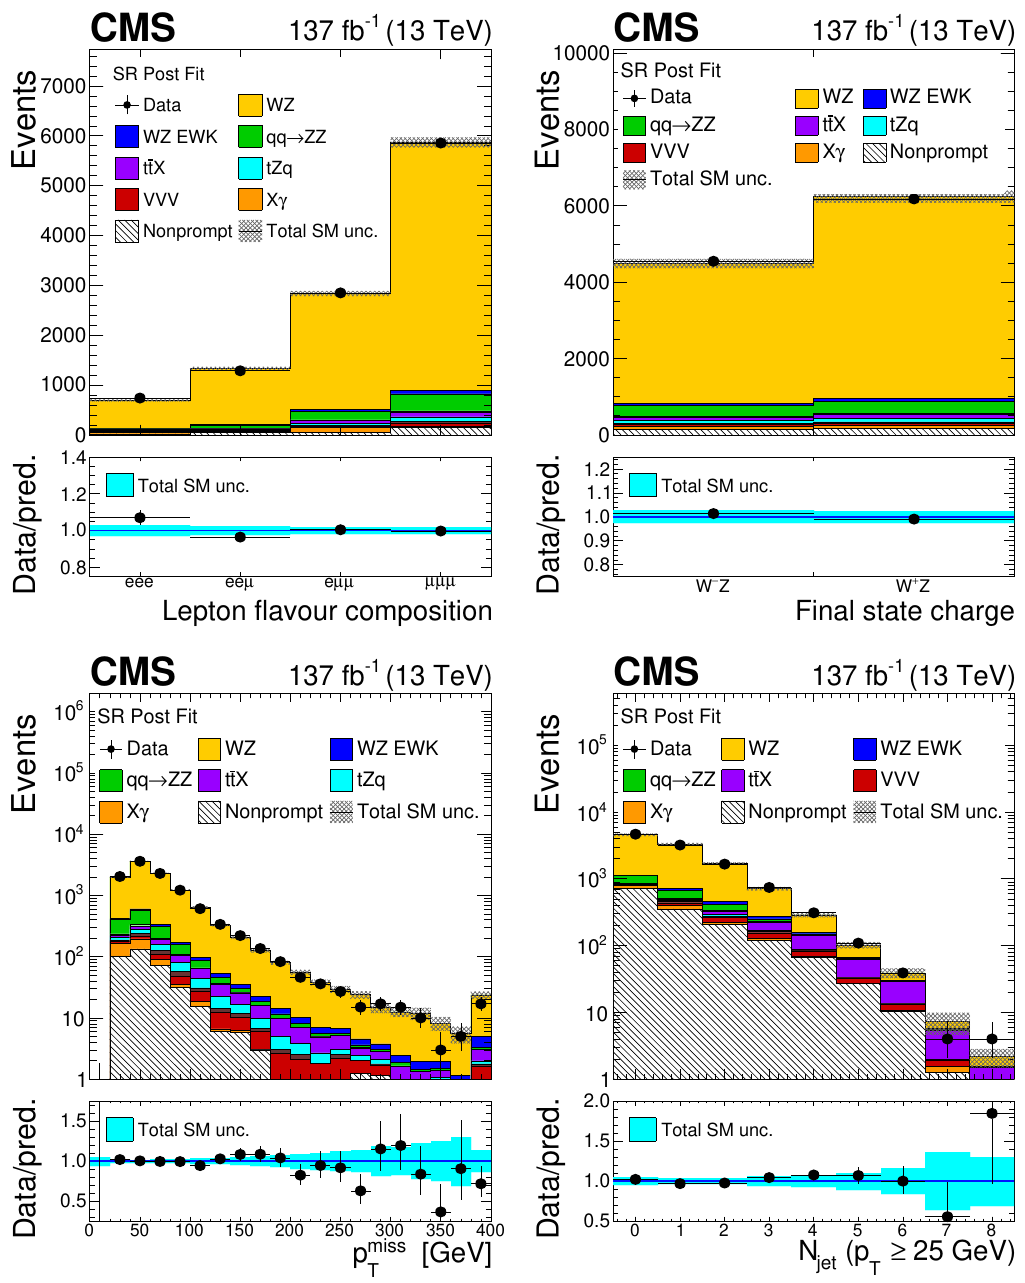
Figure 5 . Distributions of observables in the SR after the combined fit to all data-taking years and flavour final states: flavour composition of the three-lepton final state (top left), sum of charge of the final-state leptons (top right), missing transverse momentum (bottom left), and number of reconstructed jets with p greater than 25 GeV (bottom right). The label X g includes Z g , W g , T tt g , and WZ g production. The label ttX includes ttZ , ttW , and ttH production. The shaded band in the main plot area and the blue band in the ratio show the sum of uncertainties in the signal and background yields. The vertical bars attached to the data points show their associated statistical uncertainty. Underflows (overflows) are included in the first (last) bin shown for each